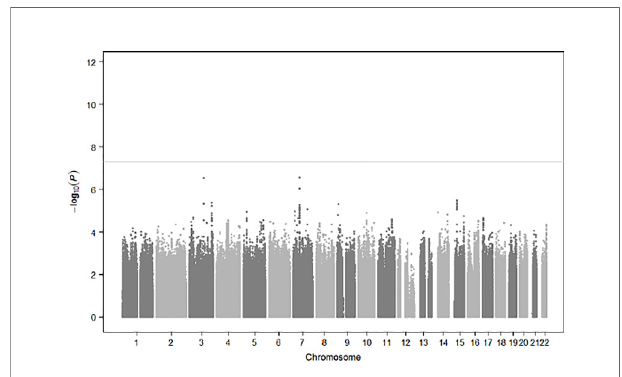
FIGURE 3 | Manhattan Plot for Genome-Wide Single SNP-Based Analysis for Prediabetes Status Change.